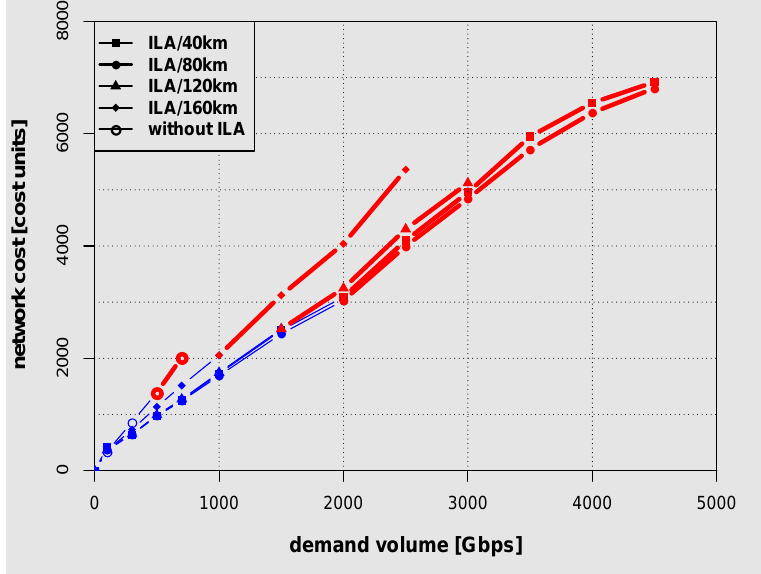
Figure 7. The dependence of network cost on the demand volume for Polish